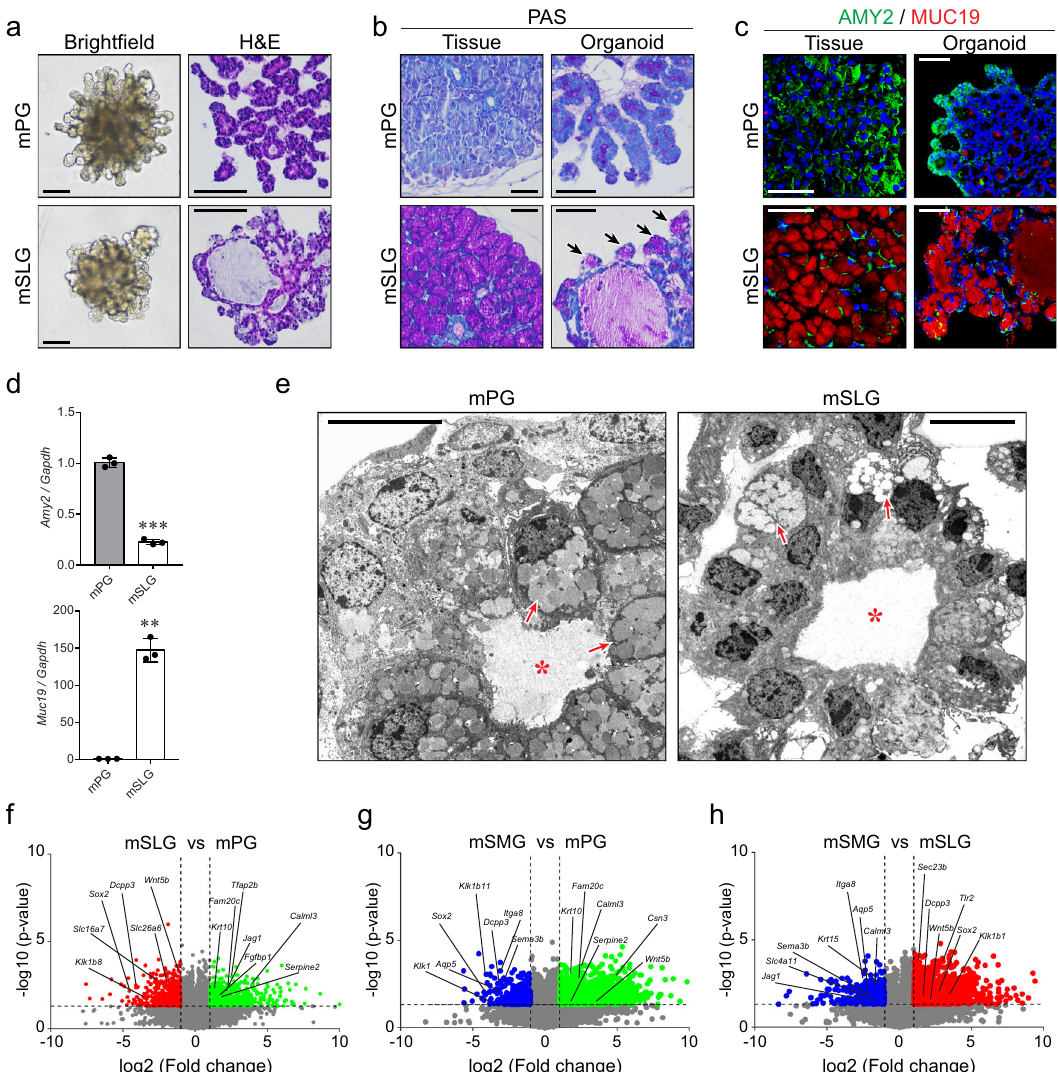
Fig. 2 Adult salivary gland organoids possessed distinct gland-speci fi c properties in mice. a – d mPG (top) or mSLG (bottom) organoids were maintained in the GEM for 9 days, followed by 3 days of differentiation in the DAM. a Representative images of bright fi eld microscopy (left) and H&E staining (right). Scale bars indicate 100 μ m. b The presence of mucin in mPG and mSLG tissues (left) or organoids (right) was assessed via PAS staining. Black arrows indicate the mucin-positive region near end buds. Scale bars indicate 50 μ m. c IF staining for PG-speci fi c (AMY2, green) and SLG-speci fi c (MUC19, red) markers in tissues (left) or organoids (right). Nuclei were stained with Hoechst 33342 (blue). Scale bars indicate 50 μ m. d PG-speci fi c Amy2 or SLG- speci fi c Muc19 gene expressions were validated via qRT-PCR in organoids. Data were presented as the mean ± SEM ( n = 3 biologically independent samples). e Transmission electron microscopy (TEM) images of mPG (left), and mSLG (right) organoids. Red asterisks indicate internal lumen. Red arrows indicate serous acinar cells or mucous acinar cells in mPG or mSLG organoids, respectively. Scale bars indicate 10 μ m. f – h Murine salivary gland organoids were maintained in the GEM for 9 days, followed by 3 days of differentiation in the DAM, and subjected to RNAseq analysis ( n = 2 biologically independent samples). f DEGs with a fold change >2 and p -value <0.05 between mPG (green) and mSLG (red) organoids depicted using a volcano plot. g DEGs with a fold change >2 and p -value <0.05 between mPG (green) and mSMG (blue) organoids depicted using a volcano plot. h DEGs with a fold change >2 and p - value <0.05 between mSLG (red) and mSMG (blue) organoids depicted using a volcano plot. ** p < 0.01, *** p < 0.001. Source Data are provided as a source data fi accumulation of somatic mutations during organoid develop- that our organoid cultures could maintain their genetic stability ment. Using whole-exome sequencing data, we detected a total of over time (Supplementary Fig. 6i, j). 119 and 130 somatic mutations in SMG tissues and organoids, Human PG, SMG, and SLG are known to have distinct serous, respectively. We observed that 104 variants were conserved seromucous, and mucous characteristics, respectively (Fig. 3f, among them, whereas 26 somatic mutations were identi fi ed as left). To determine whether the organoids recapitulated gland- acquired during organoid culture (15 nonsynonymous variants in speci fi c properties, we evaluated the presence of mucin using PAS the coding lesion, fi ve synonymous variants, and six variants in staining. We accordingly observed the presence of mucin-positive the noncoding lesion). All nonsynonymous variants were lumen in the SMG and SLG but not in the PG organoids (Fig. 3f, considered nonpathogenic (CADD phred score <25), indicating right). Furthermore, we found that mucin 7 (MUC7, a human